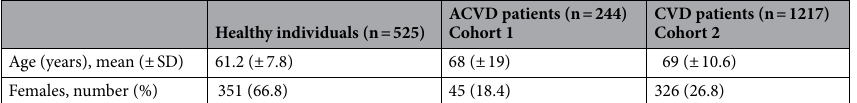
Healthy individuals (n = 525)